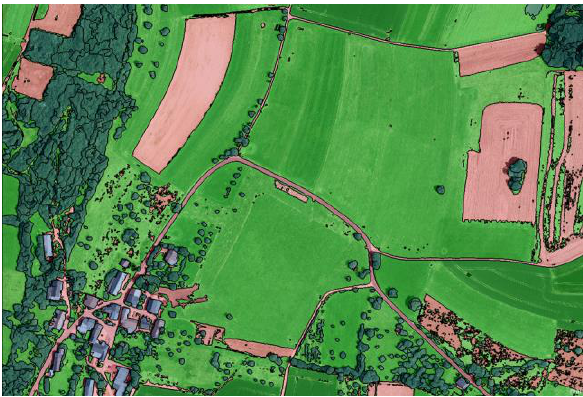
Figure 2: Threshold based segmentation of aerial image/ nDSM. High vegetation already subdivided by multiresolution segmentation, Mannebach, Saar- Mosel region (NATFLO)